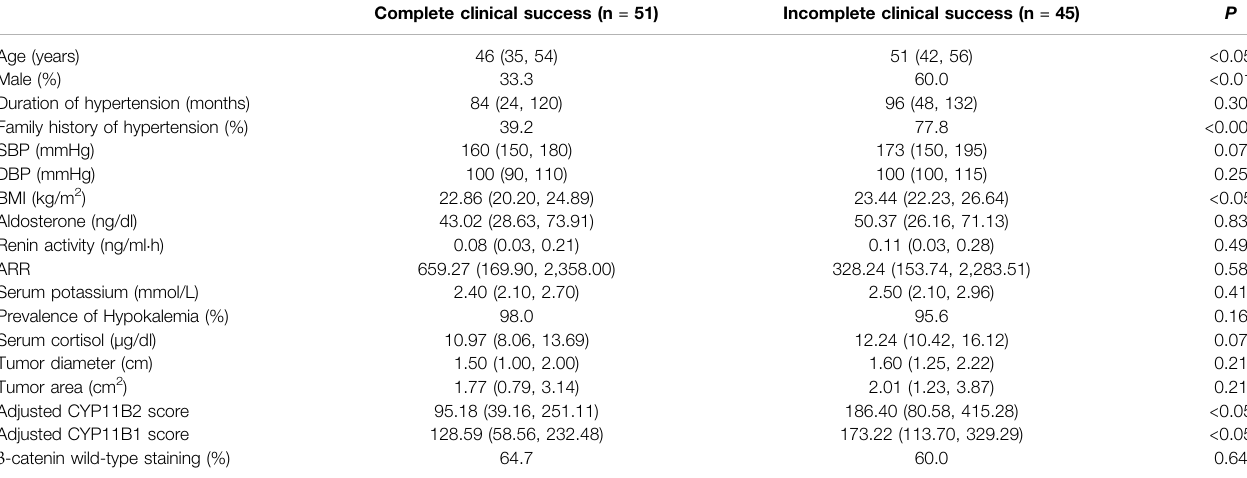
Data are expressed as median with interquartile range or proportion of patients (%). Hypokalemiaisde fi nedasspontaneousserumpotassiumconcentration < 3.5 mmol/L.Abbreviations:SBP,systolicbloodpressure;DBP,diastolicbloodpressure;BMI,bodymassindex; ARR, aldosterone to renin